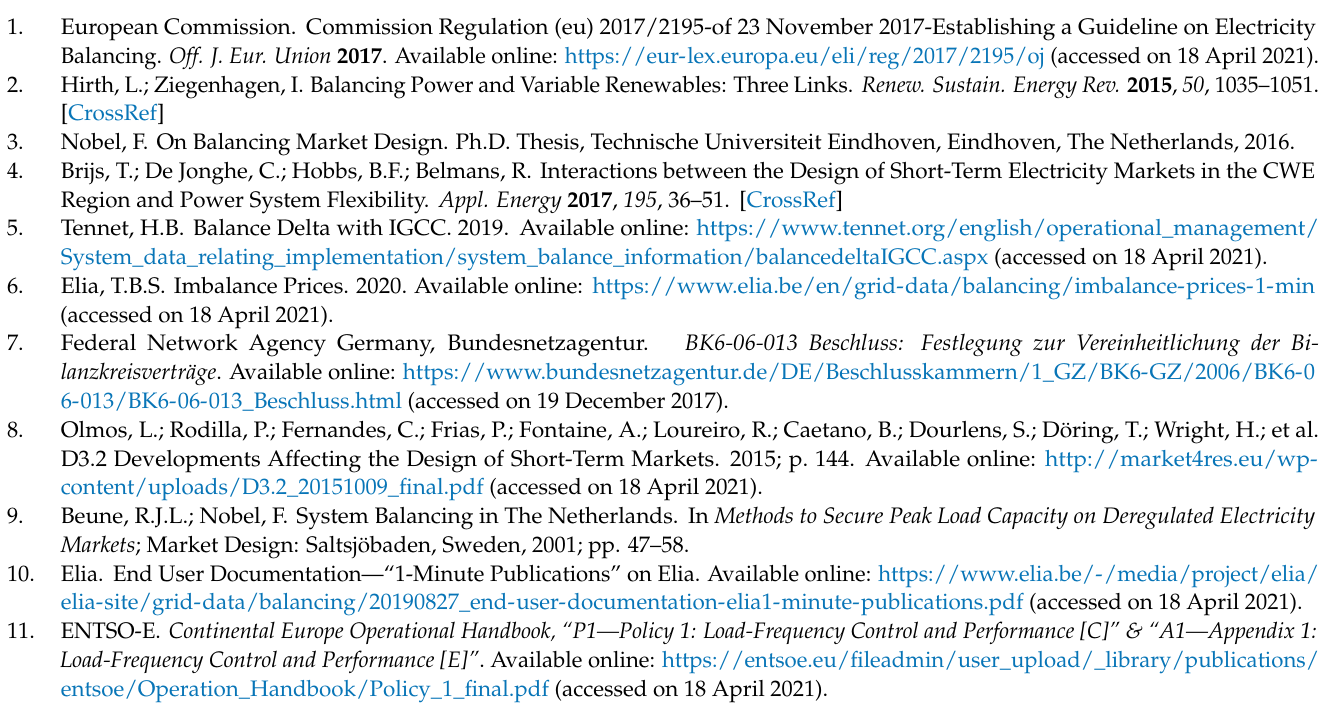
Imba sign is changed Imba sign is not changed average The presented scenarios are based on these parameters and